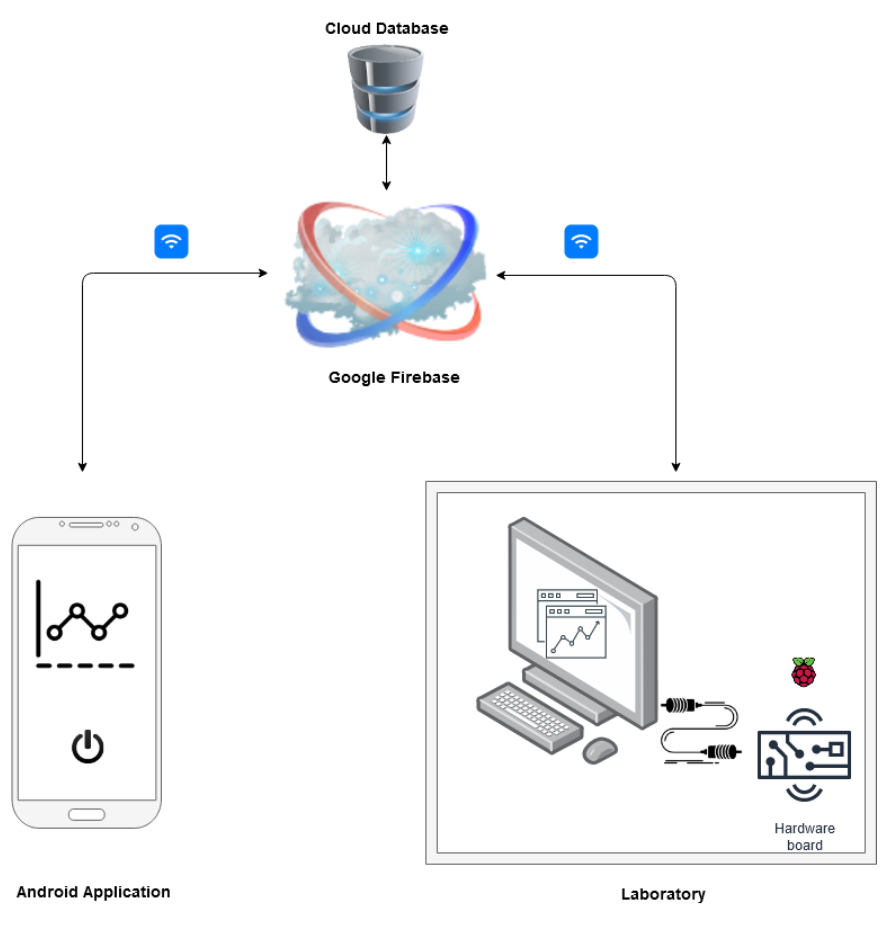
Figure 4. Overview of the connection between mobile application and controlling